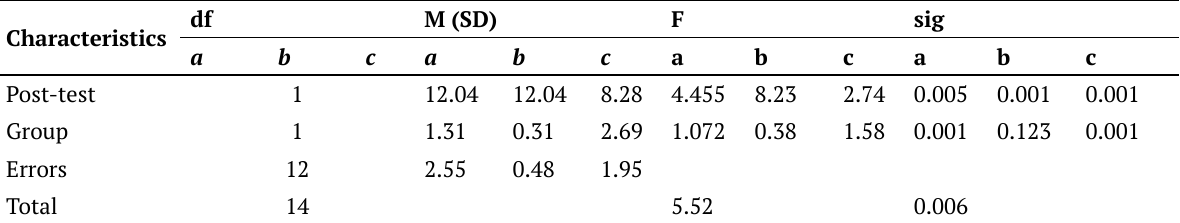
Table 4. Analysis of the covariance between the results of two pedagogical methods concerning legs attacks